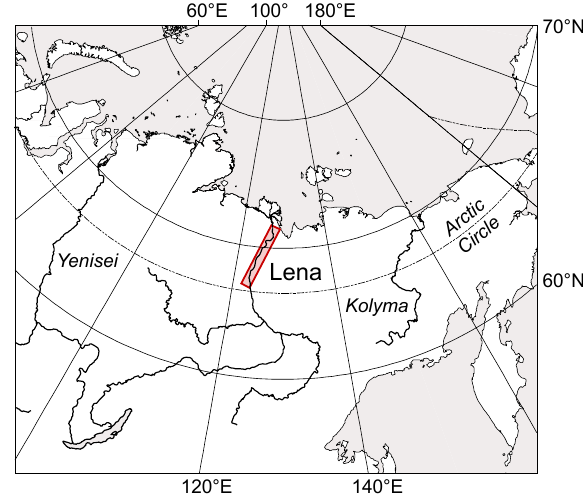
Fig. 3. Location of strip of nine ASTER stereo scenes of 27 May 2011 (red), used for ice and water velocities of Lena River,